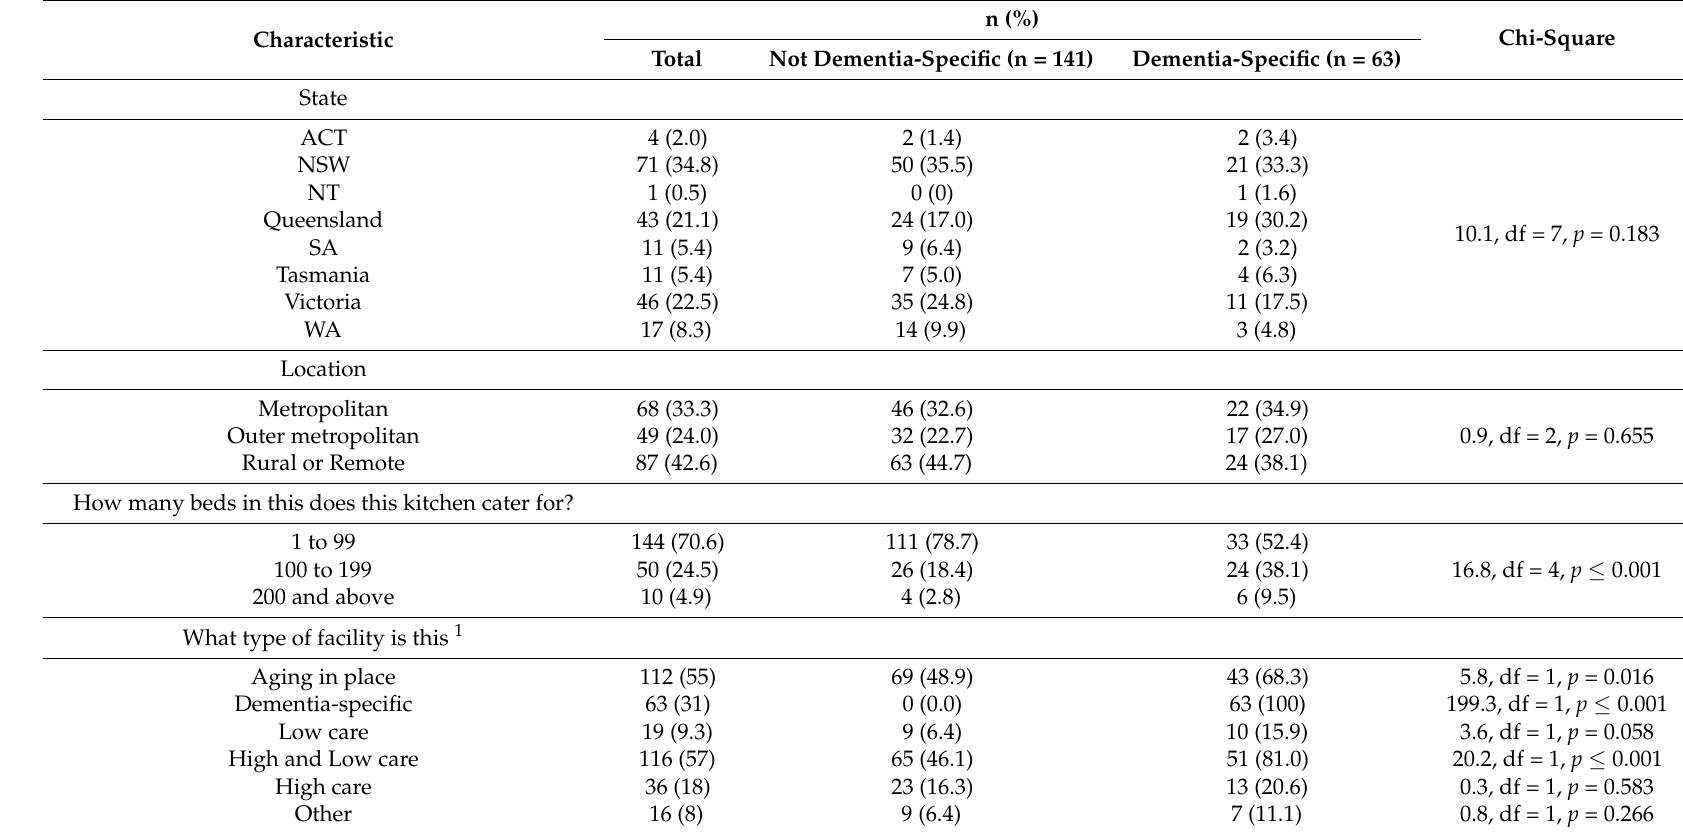
Table 1. Characteristics of responding